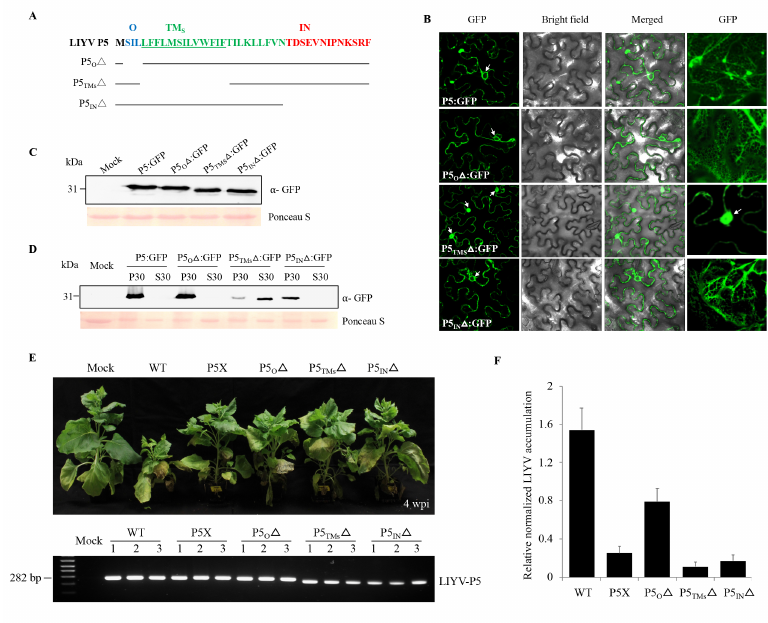
Figure 6. Evaluation of different regions of LIYV P5 contributing to viral infection. ( A ) The inner- (IN, red color), outer- (O, blue color) and trans- (TM, green color) membrane regions of P5 predicted by the SOSUI program. The minimal transmembrane (TM) region predicted is underlined. The deletion mutants of P5 were indicated by the solid lines with the names of the constructs listed at left. ( B ) Confocal imaging of P5-GFP fusion proteins containing P5 truncation mutations in Nicotiana benthamiana epidermal cells at 2 dpi obtained under a 63 × water immersion objective. Arrows indicate cell nucleus. The right GFP column shows enlarged cellular structures of the ER and nucleus. ( C ) Fusion protein expression detected by immunoblotting using a GFP specific antibody. ( D ) Cellular fractionation of P5 mutant GFP fusion proteins. The 30,000 × g pellet (P30) and supernatant (S30) fractions were analyzed by immunoblots using anti-GFP antibody. The Ponceau S stained rubisco large subunit serves as a loading control. ( E ) Phenotypes of LIYV WT and P5 mutants in agroinoculated N.